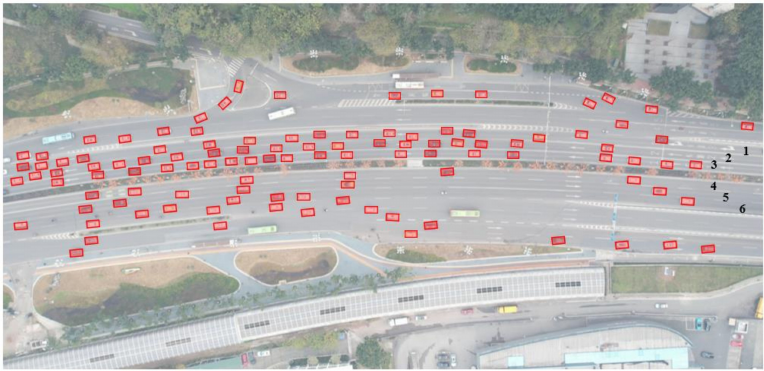
Figure 1. Processing diagram of unstructured